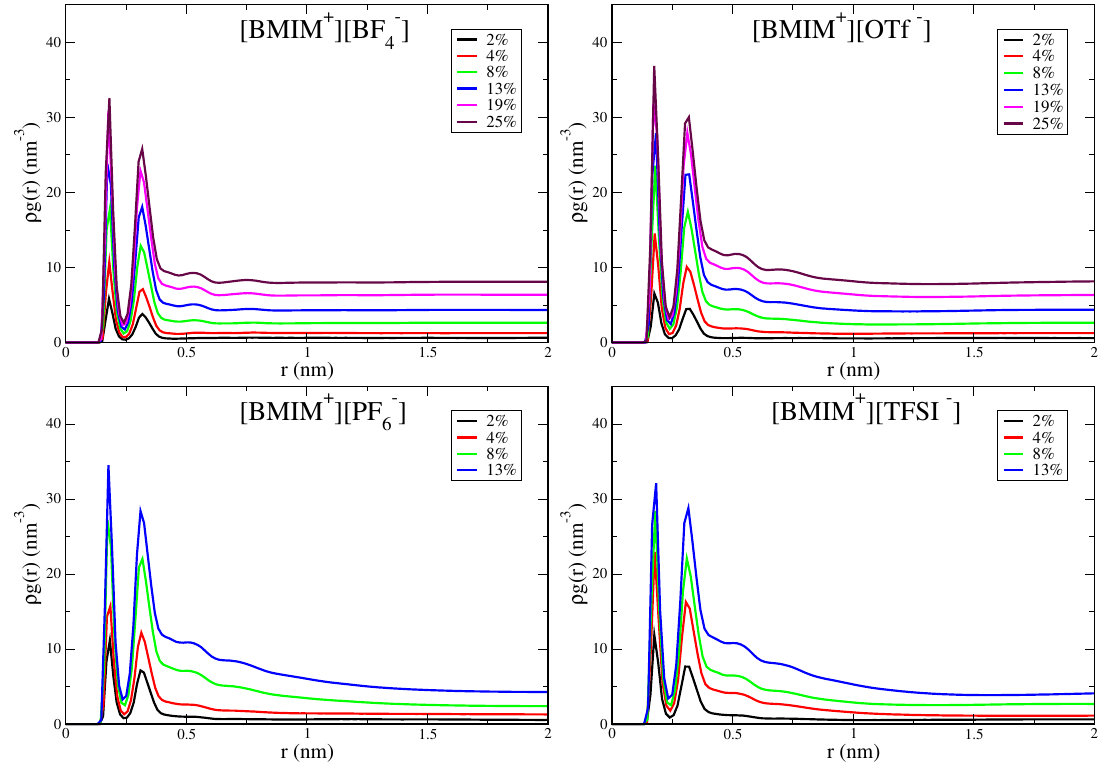
Figure 5. Pairwise probability distribution for water computed from oxygen-hydrogen distances for [BMIM + ][BF − ], [BMIM + ][OTf − ], [BMIM + ][PF − ] and [BMIM + ][TFSI − ]IL/water mixtures. 6 4 Distributions are normalized by the density of water